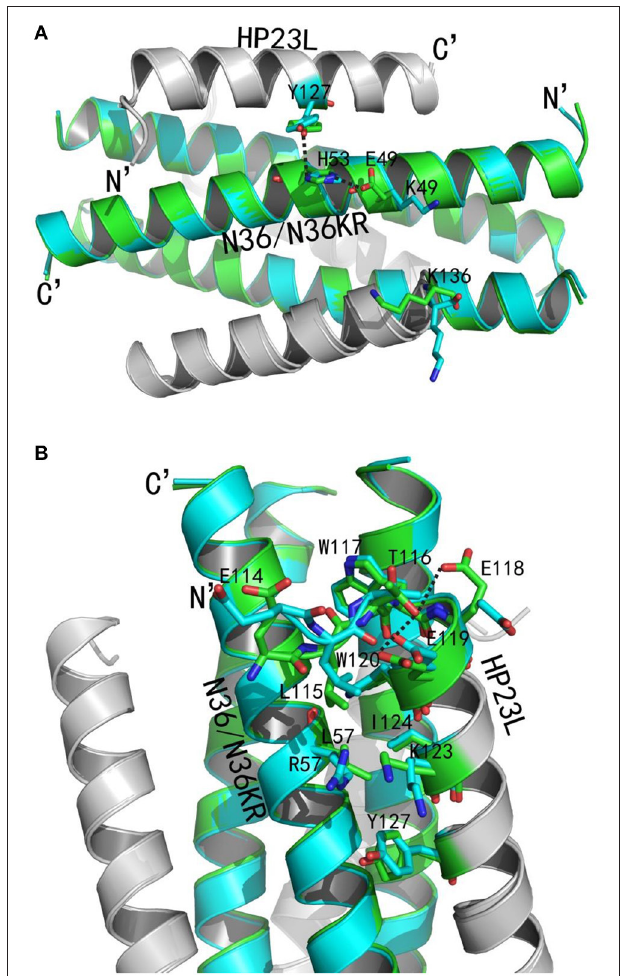
FIGURE 8 | Revealing the mechanism of HIV-1 resistance by crystal structure. The structures of HP23L bound to N36 or N36 with E49K/L57R mutations (N36KR) are superimposed for comparison. N36 and N36KR are respectively shown in green and cyan. HP23L inhibitors are shown in gray. (A) Analysis of E49K-mediated resistance. The residues related to the resistant site are shown as stick models with labels. The salt-bridge and hydrogen bonds are indicated in dashed black lines. (B) Analysis of L57R-mediated resistance. The N-trimer, inhibitors, and the residues related to the resistant site are shown and labeled as (A) . A hydrogen bond in the hook region is indicated in dashed black